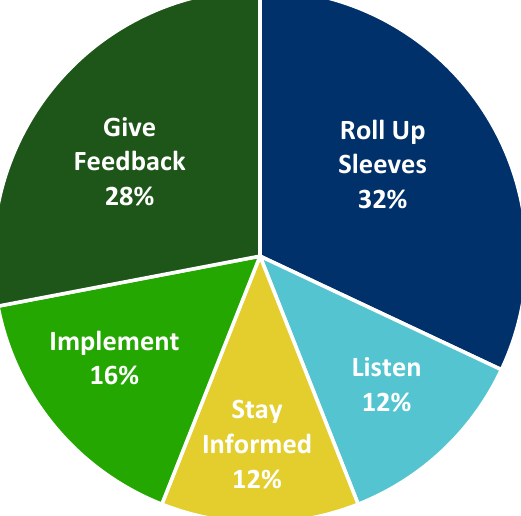
Figure 7. Levels of participant availability for ongoing